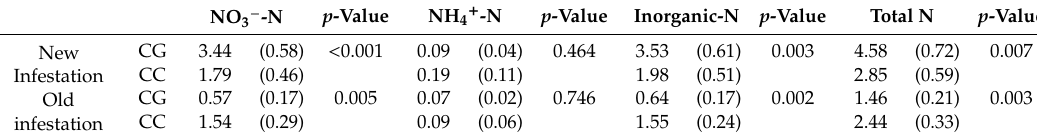
Table 6. Mean ( ± standard error) annual NO 3 − , NH 4 + , and total N values in soil solution (mg L − 1 ) for the old and new infestations across the Canopy Gap (CG) plots and Canopy Closed (CC) plots.